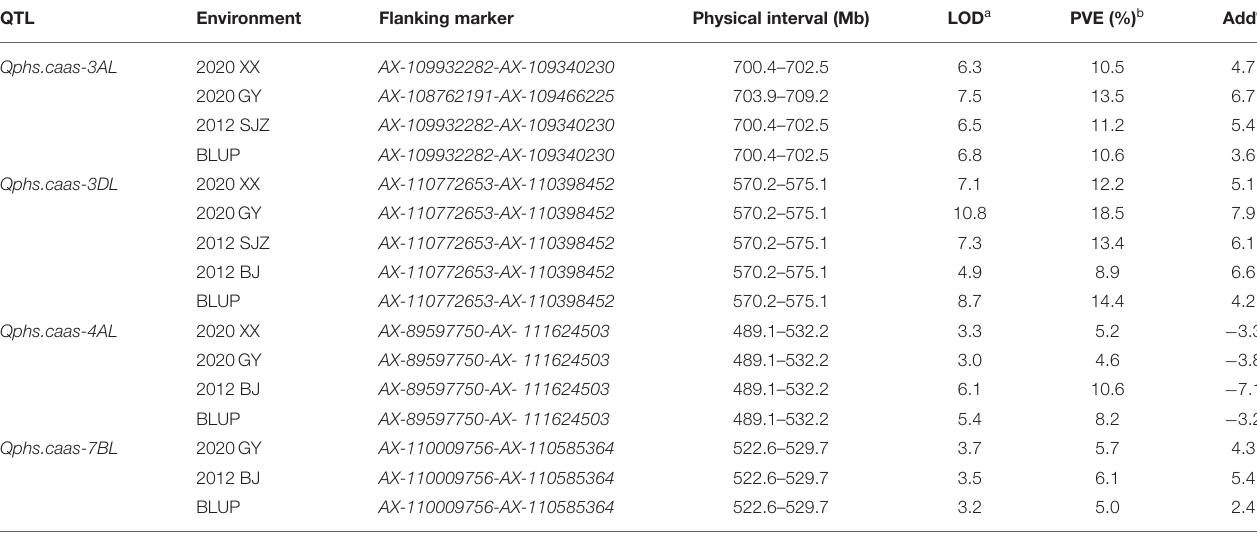
TABLE 1 | QTL for GI detected in the Yangxiaomai/Zhongyou9507 RIL population. QTL Environment Flanking marker Physical interval (Mb)